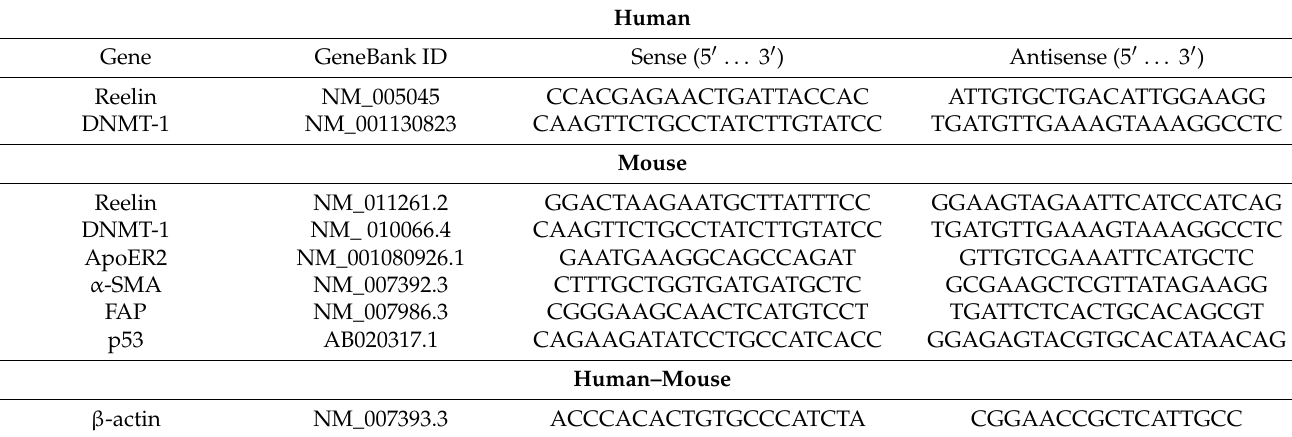
Table 1. Oligonucleotide sequences used for real-time PCR assays.